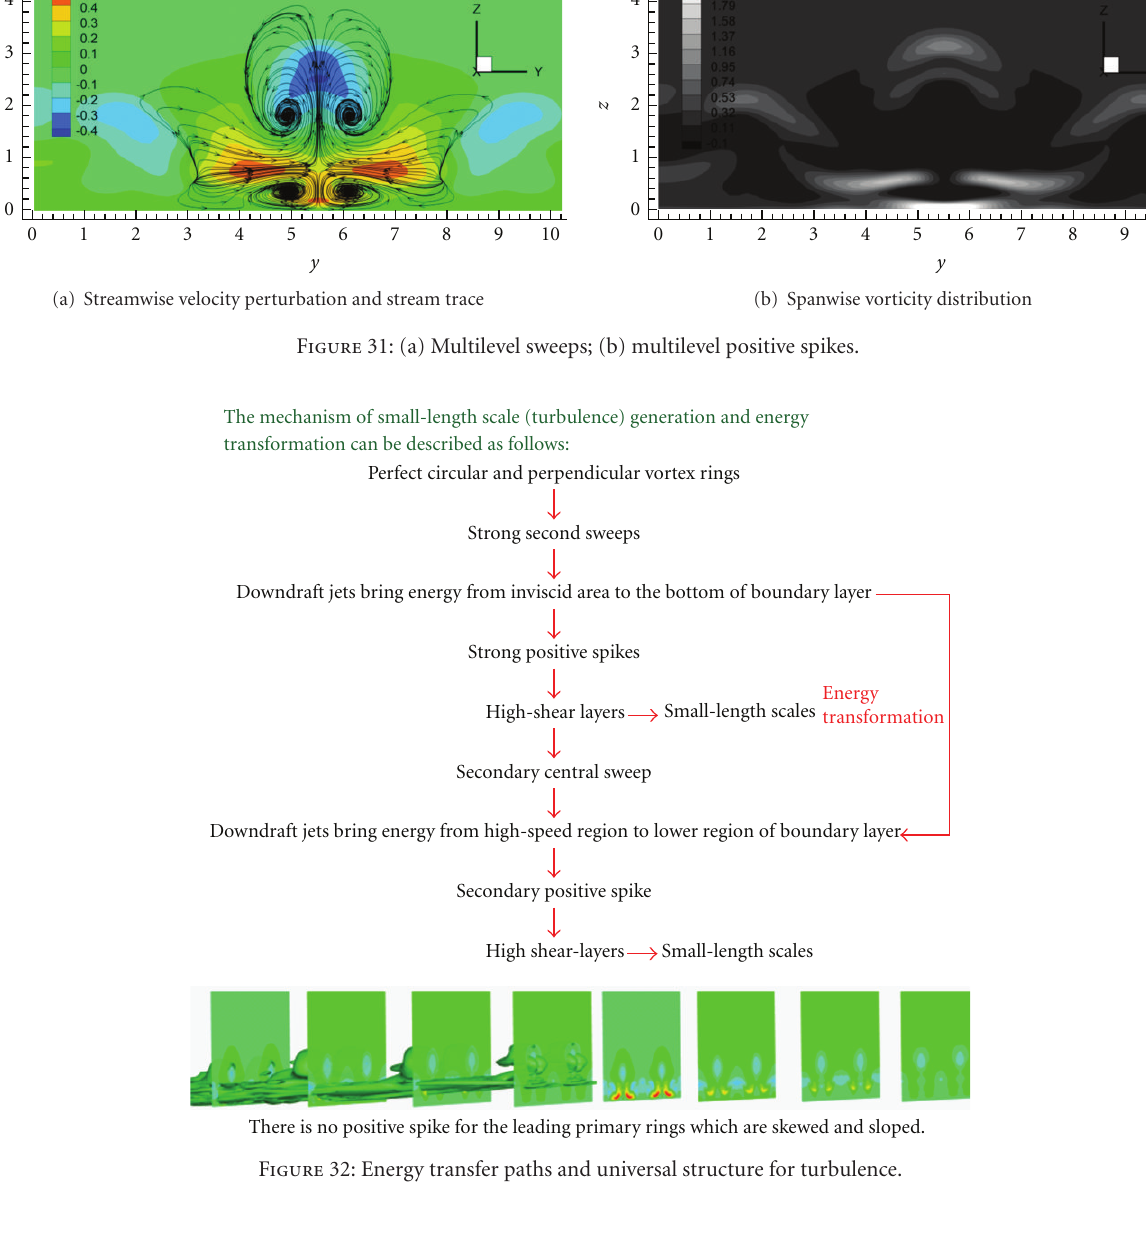
(Figure 36). The nonsymmetric structure of second level rings will influence the small length scale at the bottom quickly. The change of symmetry in the bottom of the boundary layer is quickly spread to the up level through ejections. This will lead to randomization of the whole flow field. Therefore, the internal instability of multiple level ring spot overlapping structure, especially the middle ring